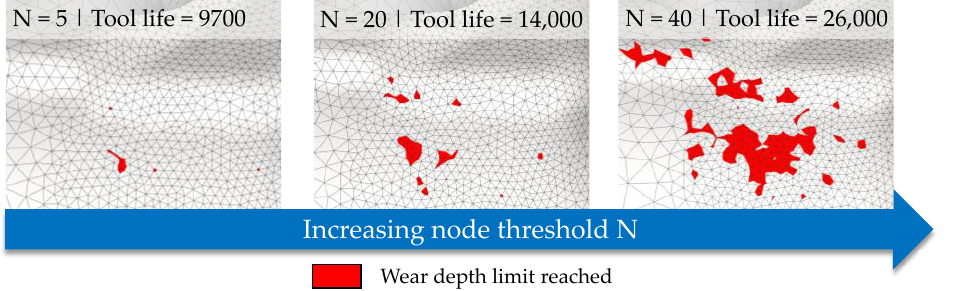
Figure 12. Affected tool surface area regarding the defined node threshold N.